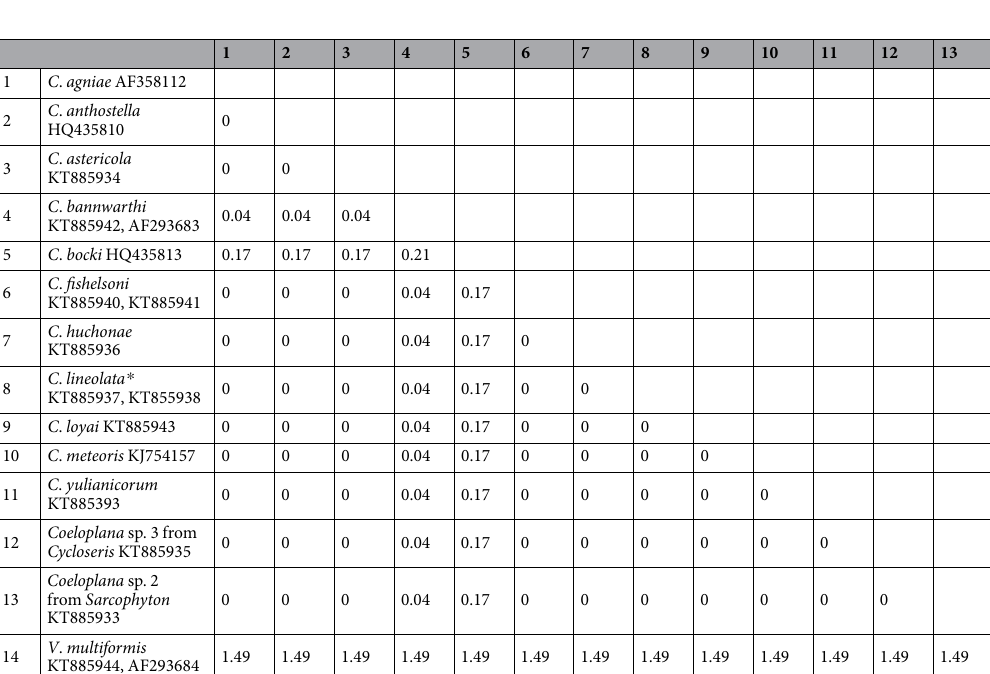
Figure 1. 18S rDNA maximum likelihood tree. The phylogenetic reconstruction was based on 1,746 bp from the 18S rDNA gene. ML bootstrap support/Bayesian posterior probabilities are indicated near the corresponding nodes. Sequences generated in the framework of this study are highlighted in bold. Coeloplanidae species considered valid based on the COI analysis are indicated by different colors.